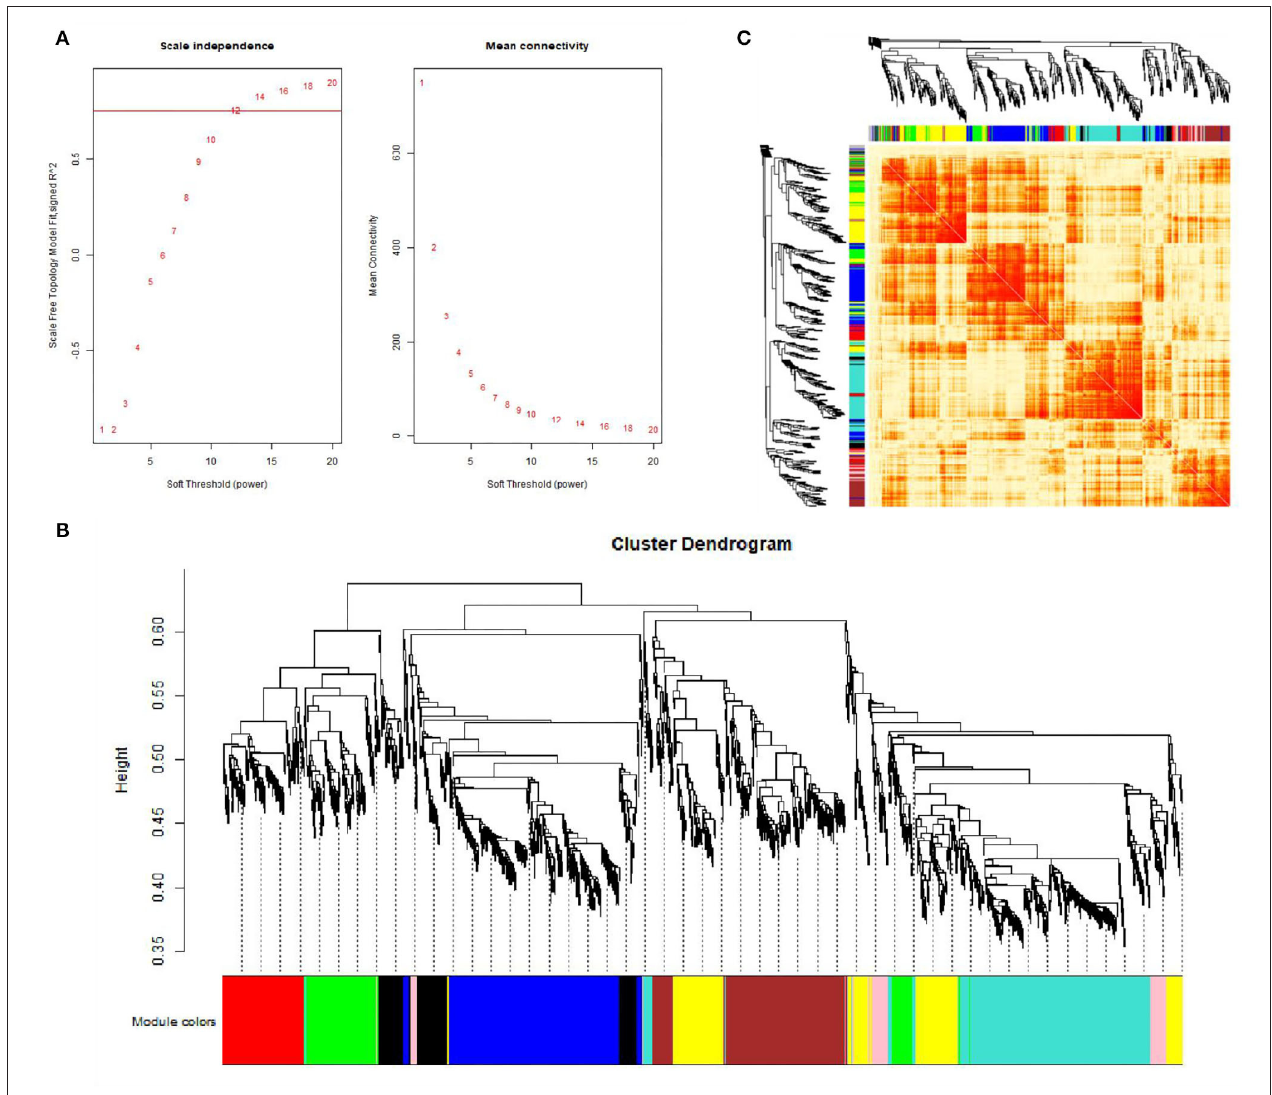
FIGURE 2 | Gene co-expression networks in subcutaneous adipose tissue (GSE116775). (A) Analysis of the scale-free fit index for soft-thresholding powers (left) and the mean connectivity for various soft-thresholding powers (right); (B) Gene expression clustering tree and recognition module in co-expression network; (C) Network heatmap plot in the co-expression